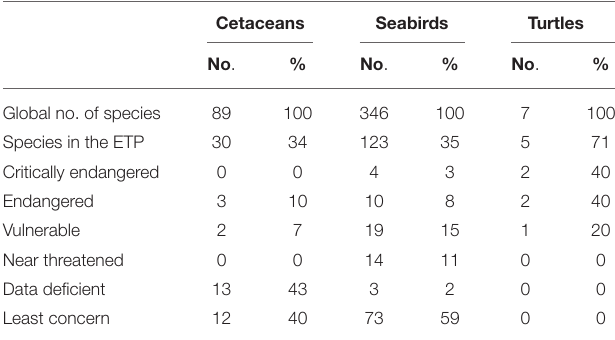
TABLE 3 | Summary of cetacean, seabird, and marine turtle species and conservation status for the eastern tropical Pacific (ETP). Cetaceans